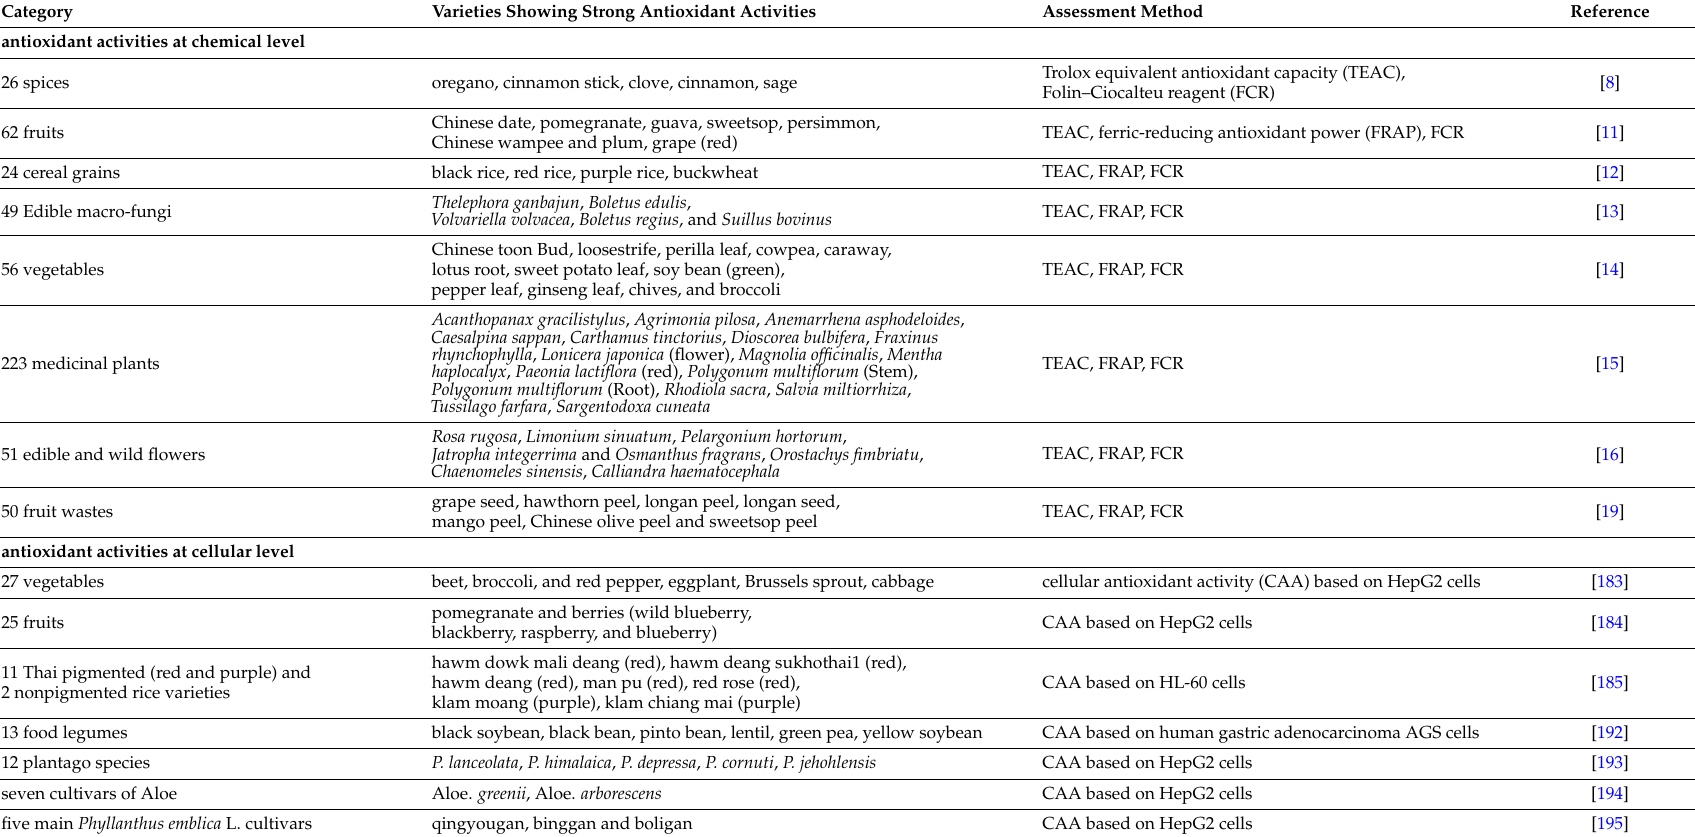
Table 3. The antioxidant capacities of some foods and medicinal